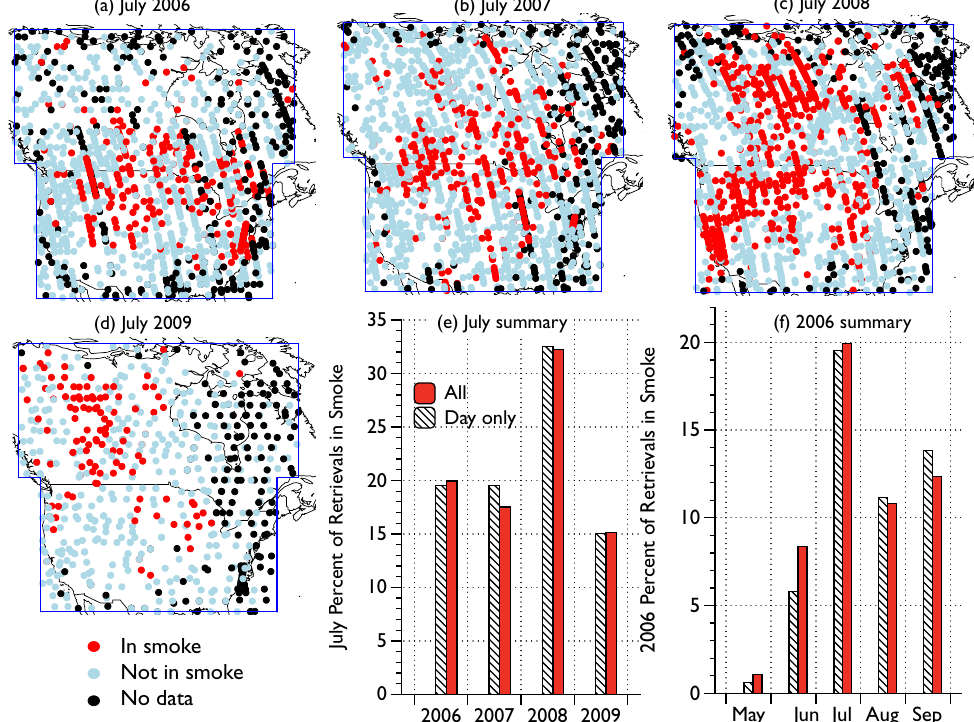
Figure 4. Panels (a) through (d) : PAN TES retrievals with DOF>0.6 co-located with NOAA Hazard Mapping System smoke polygons (red), and PAN TES retrievals with DOF>0.6 not co-located with NOAA Hazard Mapping System smoke polygons (grey). The black dots indicate PAN TES retrievals with DOF>0.6 during times with no NOAA HMS data. The blue lines surround the regions included in the distributions shown in Fig. 5: 125–70 ◦ W, 30–50 ◦ N and 130–65 ◦ W, 50–70 ◦ N. (e) Percent of TES PAN retrievals overlapping HMS smoke plume polygons for July 2006–2009. (f) Percent of TES PAN retrievals overlapping HMS smoke plume polygons for May–September 2006. In panels (e) and (f) the red bars indicate the percentage of all retrievals overlapping smoke plumes, and the striped bars indicate the percentage of daytime retrievals overlapping smoke plumes. Pairing was done using the matching UTC